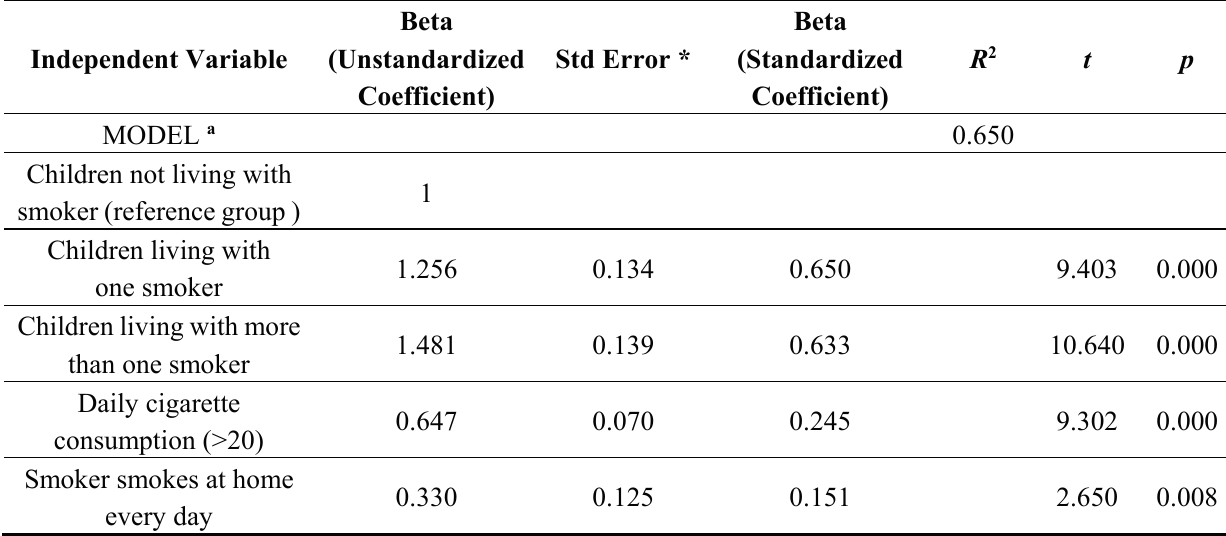
Table 3. Differences in urinary cotinine levels for children living with smokers and the smoking behaviors of the